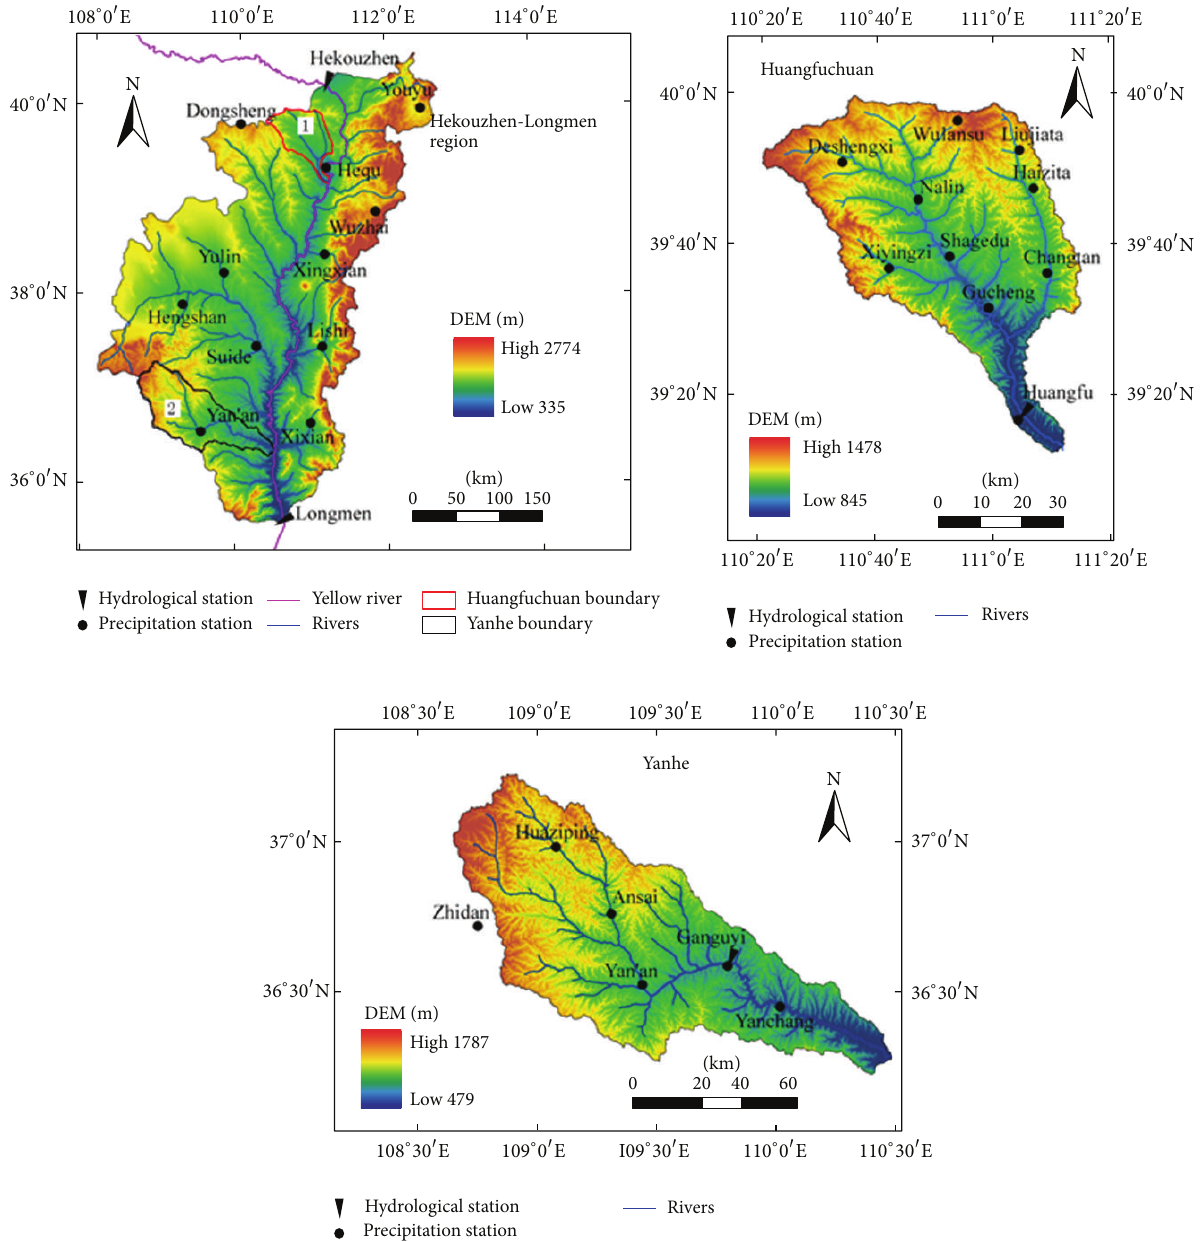
Figure 1: Location of the study area, precipitation stations, and hydrological